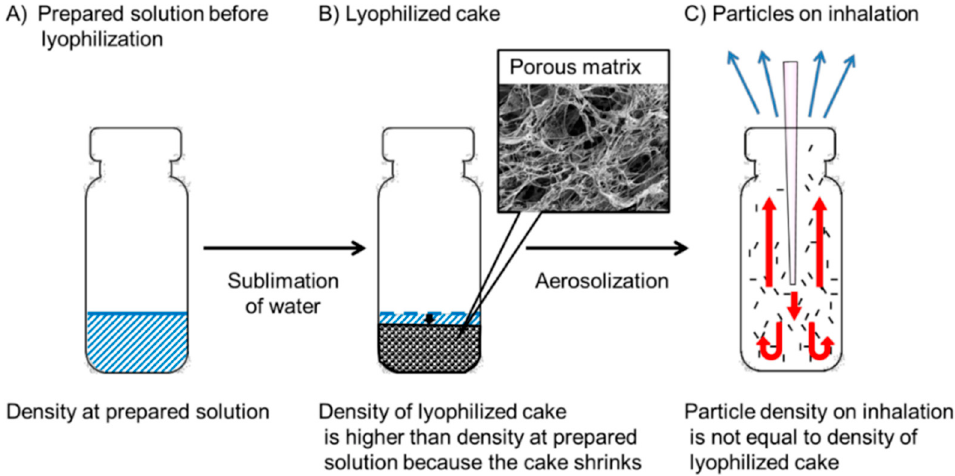
Figure 4. The density at each stage of lyophilizate for dry powder inhalation: ( A ) Stage 1, prepared solution before lyophilization; ( B ) Stage 2, lyophilized cake; and ( C ) Stage 3, particles on inhalation.